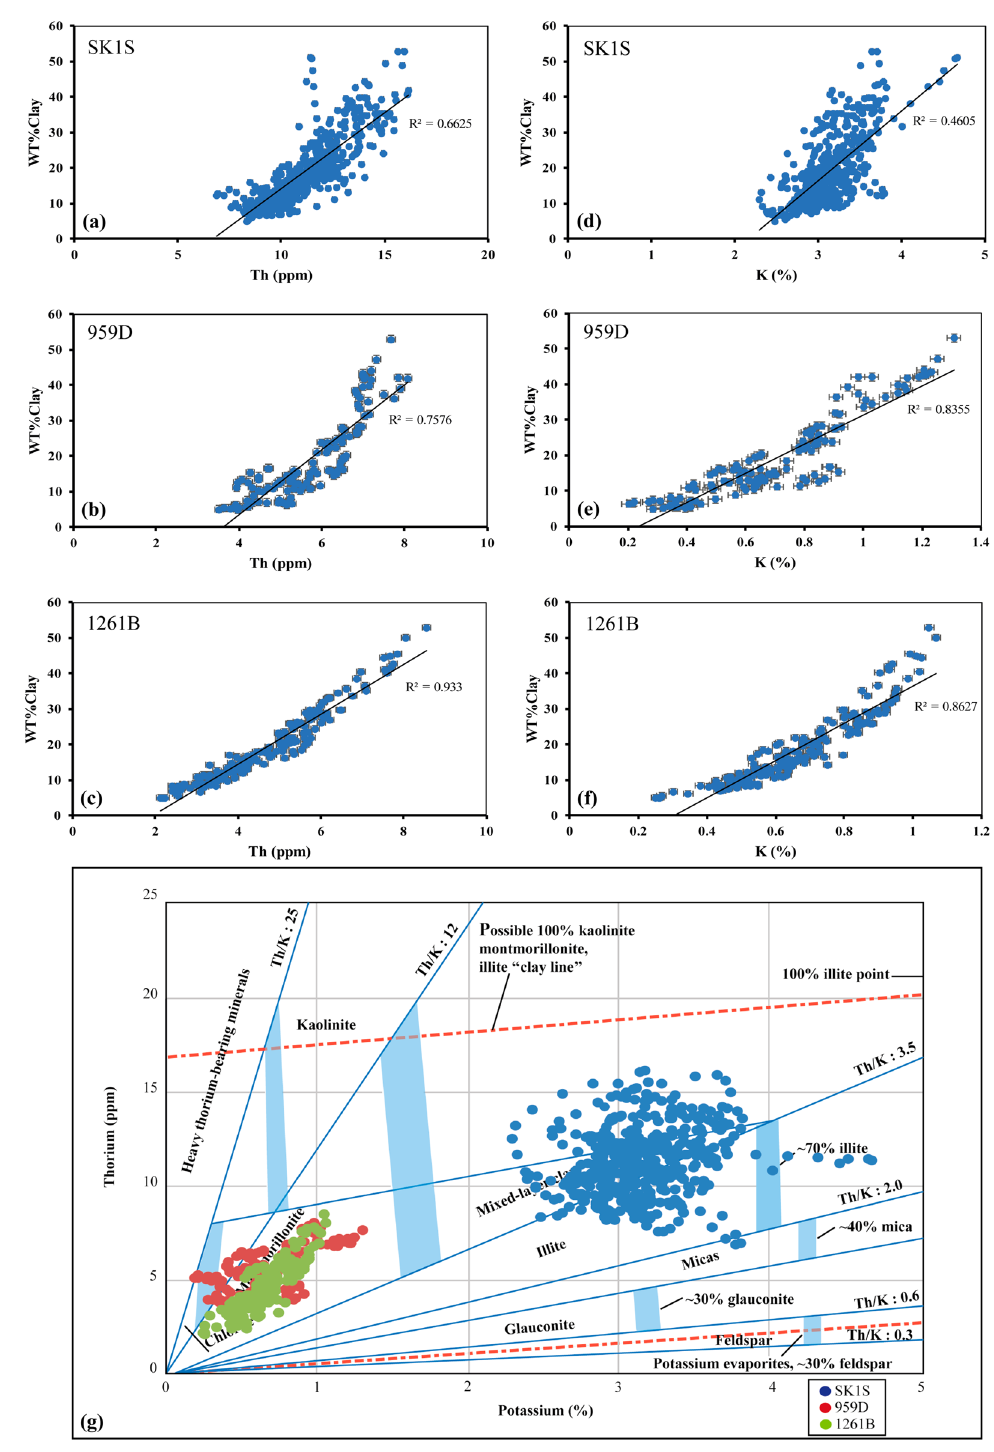
Figure 8. Correlation between the weight percent of clay, Th and K contents; and Clay minerals evaluation in the OAE3 sections recorded in Songliao Basin, Deep Ivorian Basin and Demerara Rise based on Schlumberger reference thorium–potassium cross-plot (log interpretation charts